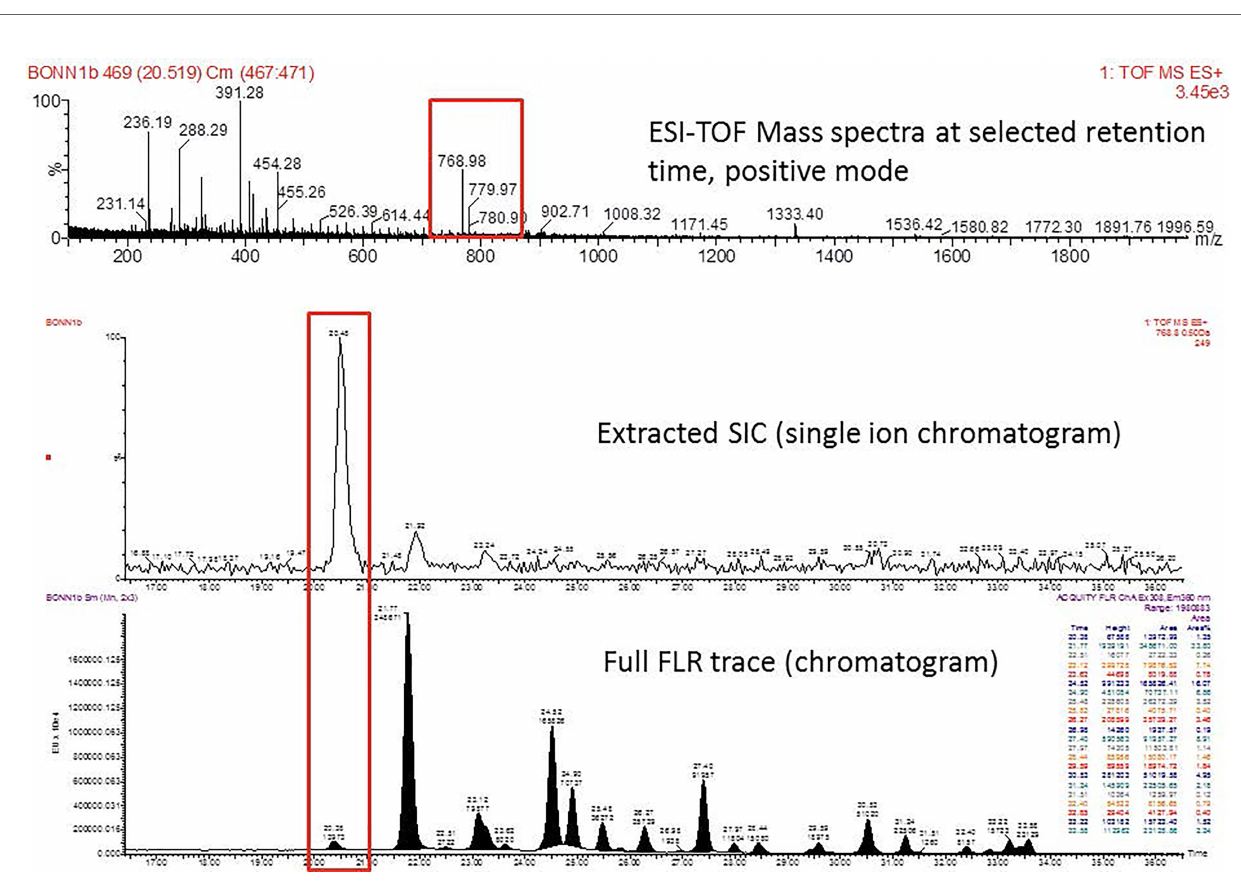
FIGURE 2 | Peak assignment strategy. Pro fi les of procainamide-labeled fl uorescent N-glycans from isolated IgG samples were obtained by HILIC UPLC-FLD/ESI- MS. Peaks were assigned according to the retention times. The graph displays a representative ESI-TOF mass spectra, a peak selection at 768.8 m/z (upper panel), the corresponding extracted Single Ion chromatogram (SIC), and full FLR trace chromatogram (middle and lower